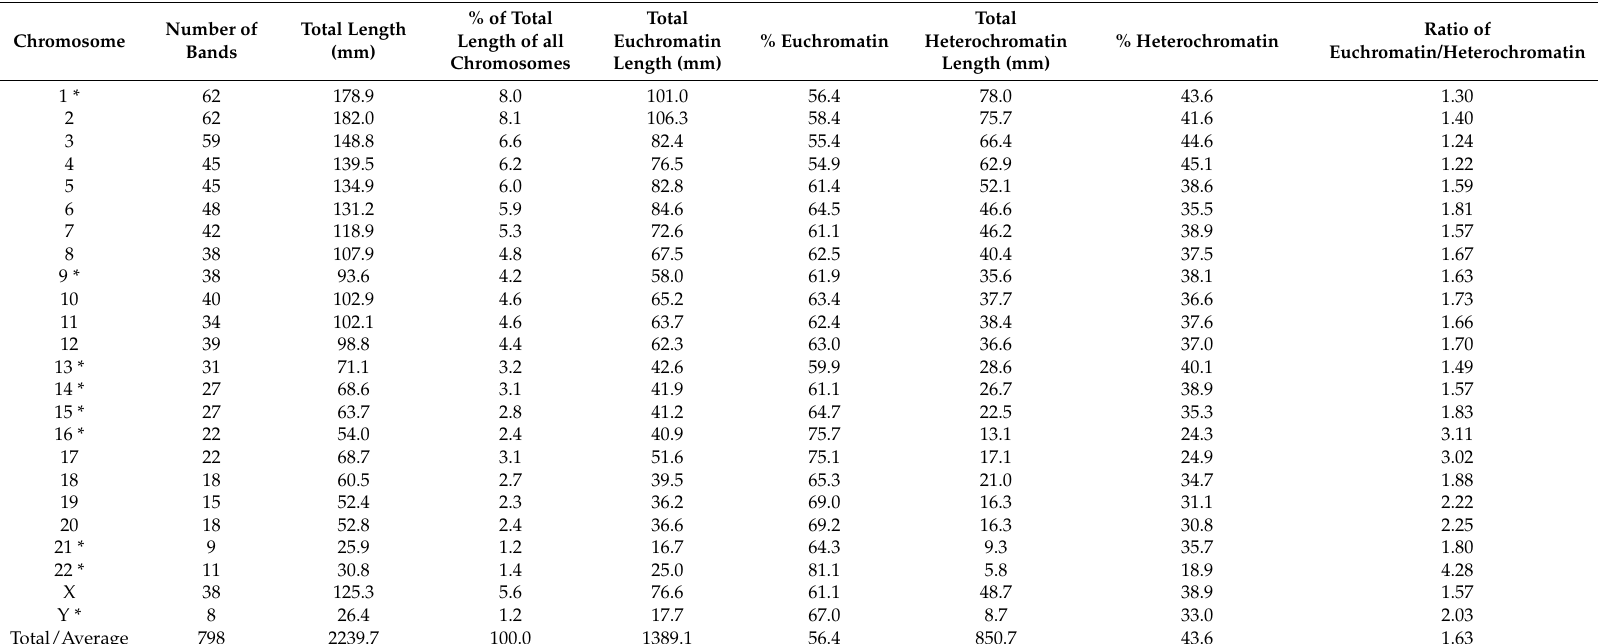
Table 1. High-resolution chromosome ideogram measurements and Giemsa banding